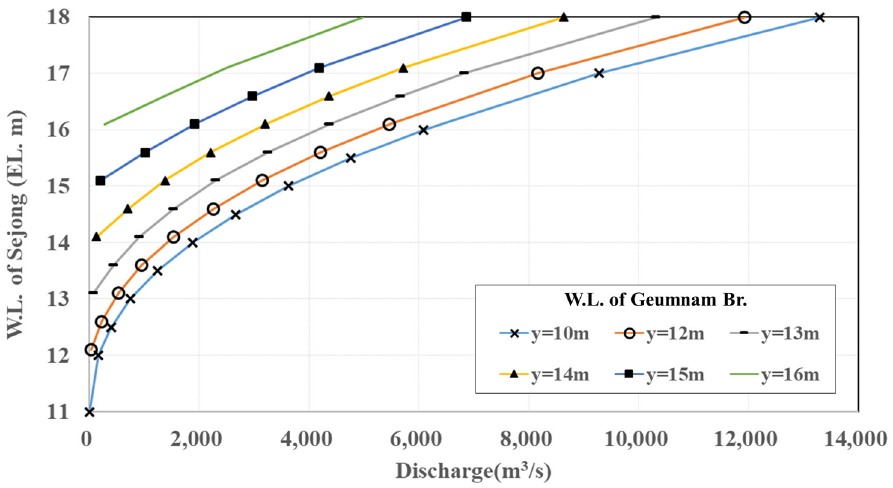
Figure 4. Rating curve considering the backwater effect based on 38 measured data points.